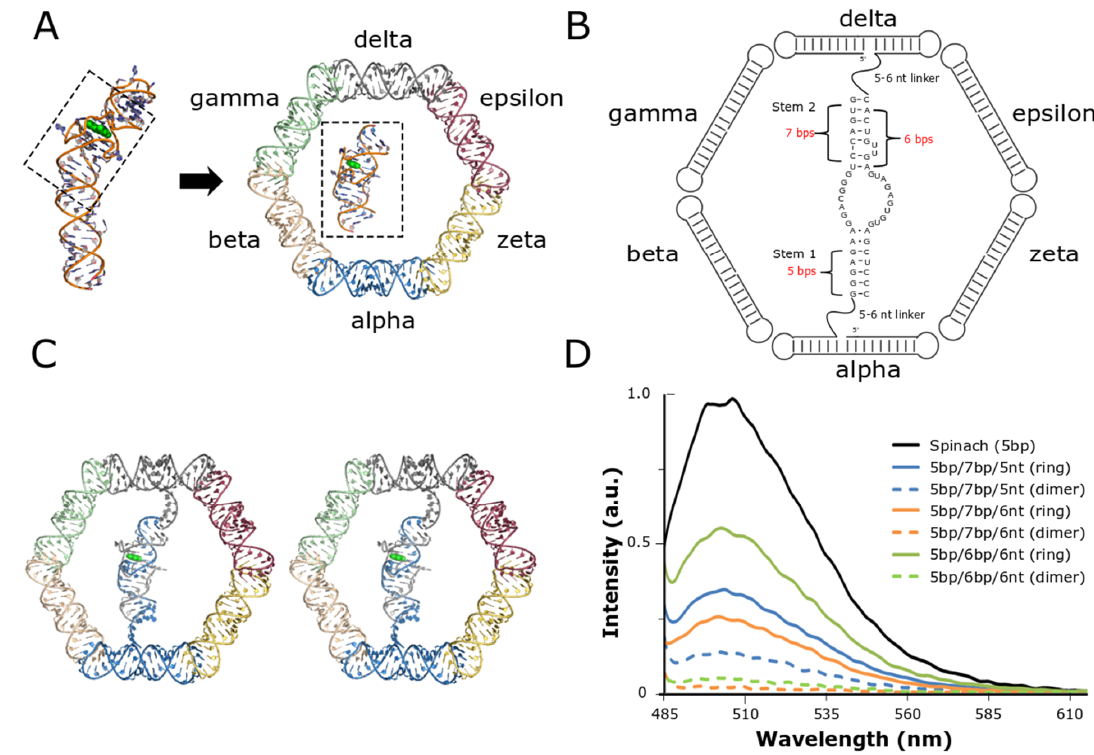
Figure 1. Design and integration of the split-Spinach aptamer and RNA nanoring. ( A ) The central portion of the Spinach aptamer crystallized by Huang et al. (PDB ID: 3IVK) [42] was placed in the interior of the previously reported RNA nanoring and grafted onto two of the nanoring’s opposing helical struts. Based on initial placement, the Spinach aptamer was modeled to contain two short stems and single-stranded linkers with variable lengths. ( B ) 2D diagram resulting from initial modification and modeling of the split-Spinach aptamer into the RNA nanoring. ( C ) Stereoview of split-aptamer integrated into RNA nanoring. ( D ) The variable stem and single-stranded linker lengths were tested via fluorescent spectroscopy in the presence of the light-up chromophore DFHBI. The combination containing 5- and 6-bp stems and 6-nt linkers (5bp/6p/6nt) showed the highest response and was therefore chosen as the initial base model for further